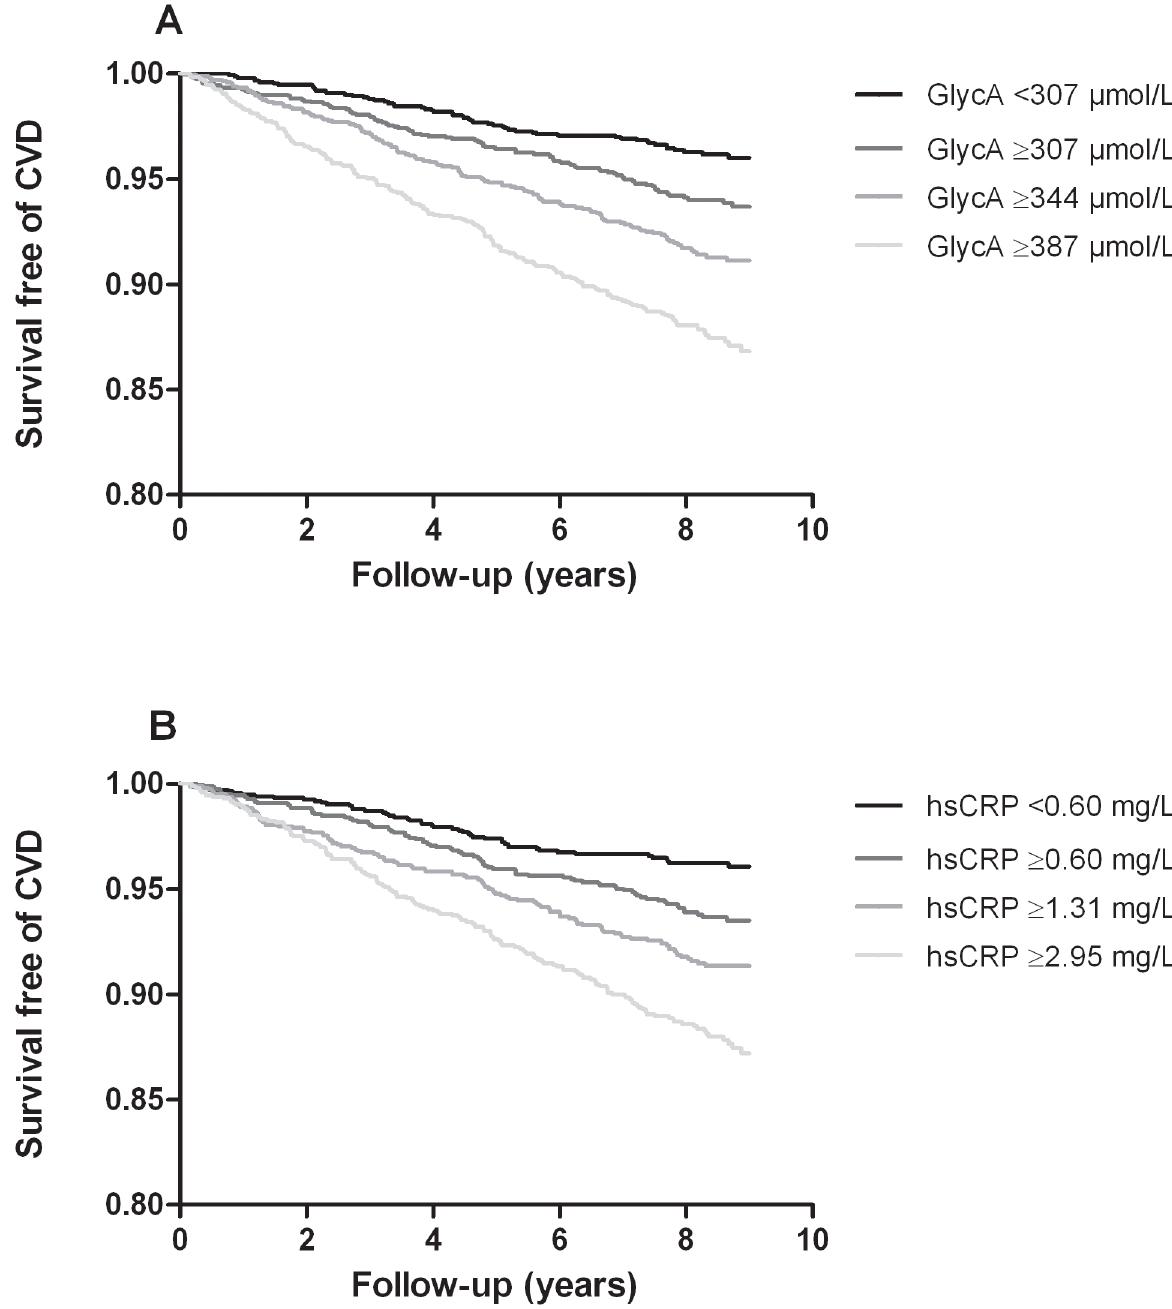
Fig 2. Kaplan-Meier curves showing incident cardiovascular events according to GlycA, P (cid:3) 0.001 by log-rank test (A) and high sensitivity C- reactive protein (hsCRP), P (cid:3) 0.001 by log-rank test